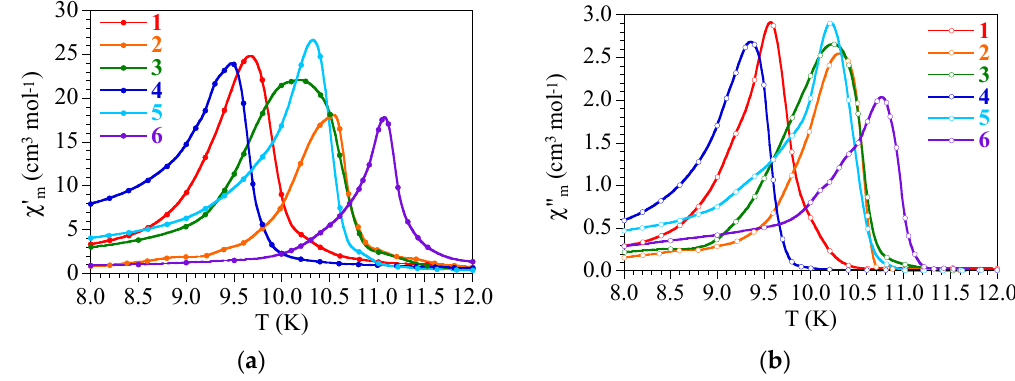
Figure 9. ( a ) Thermal variation of χ ’ m ( a ) and χ ” m ( b ) at 110 Hz for compounds 1 – 6 .